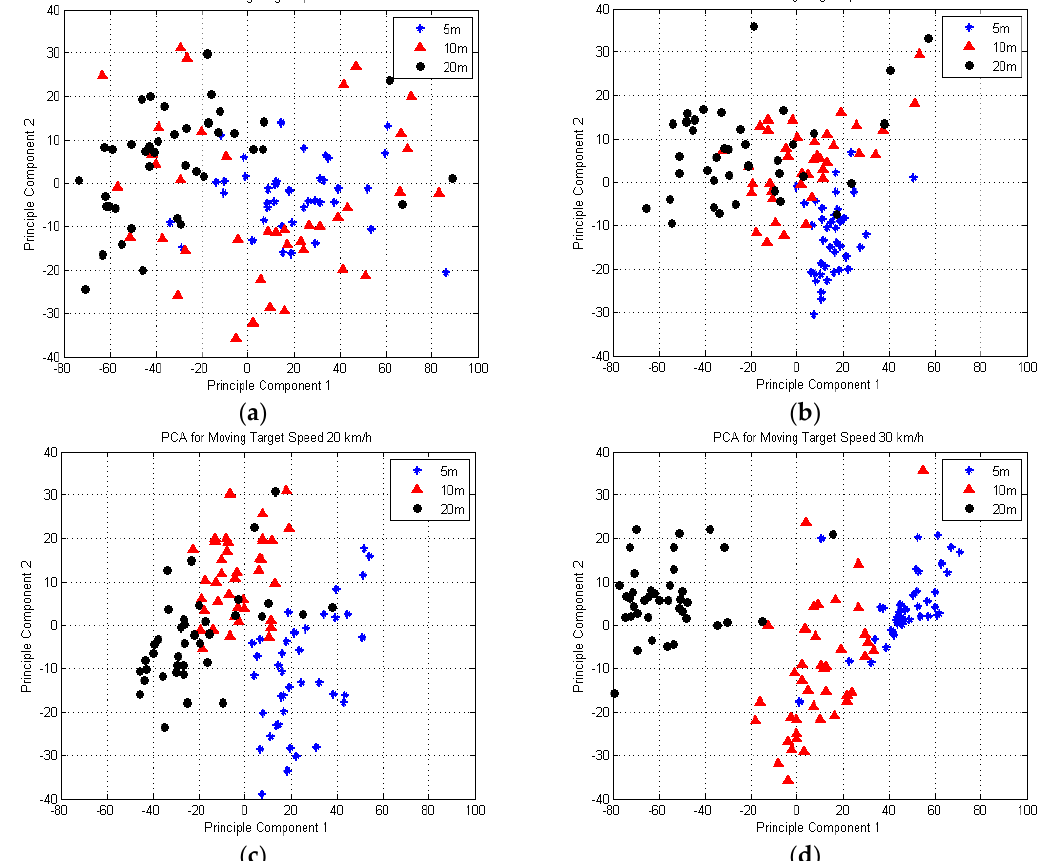
Figure 11. Location of training data for ground moving target with speed of ( a ) 5 km/h; ( b ) 10 km/h; ( c ) 20 km/h and ( d ) 30 km/h in the PCA space.